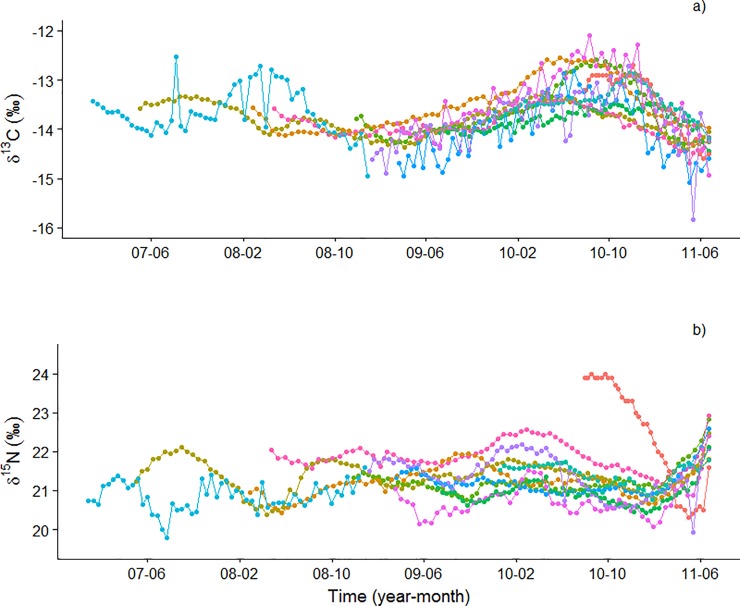
δ13C and δ15N isotope profiles over time in vibrissae from adult female California sea lions from San Esteban Island, Gulf of California.